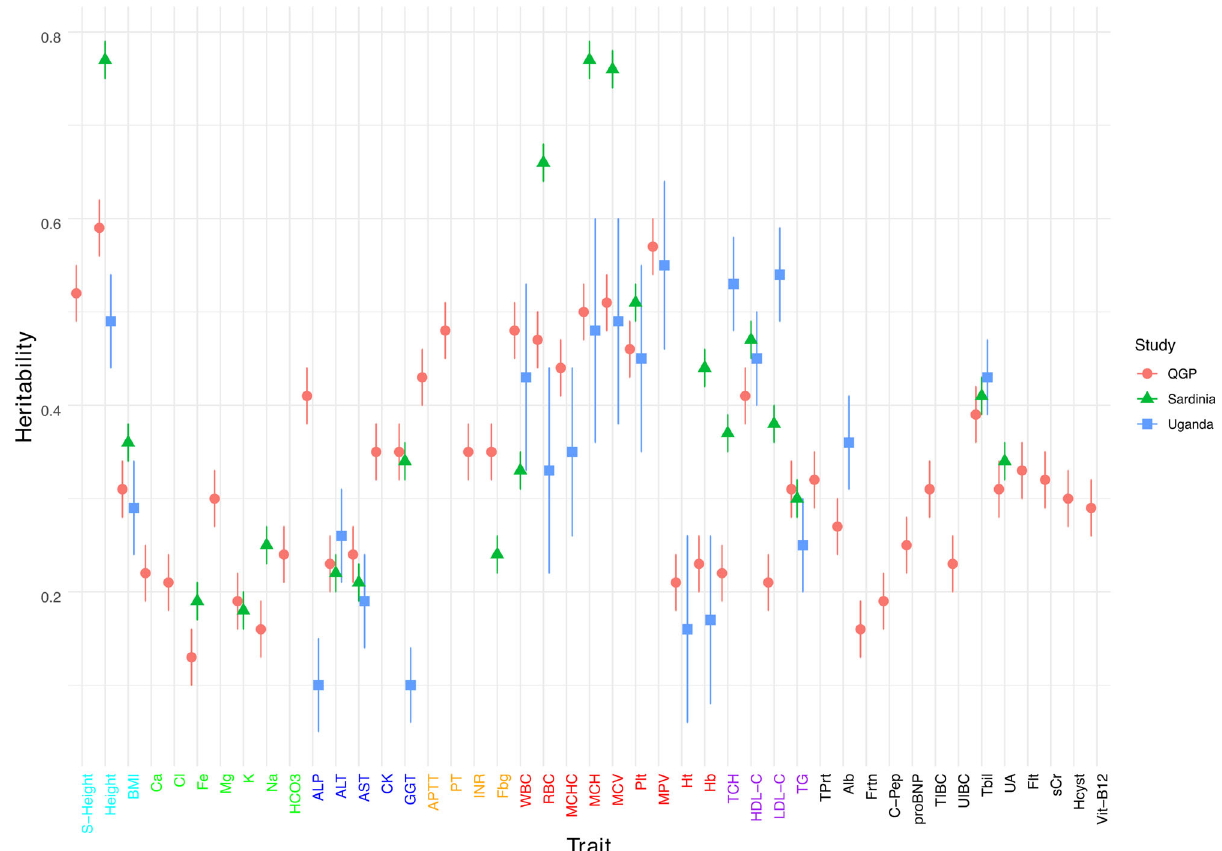
Fig. 1 Heritability estimates of 45 clinically-relevant traits. Heritability estimates of 45 clinically-relevant traits in the Qatar Genome Program cohort (QGP; red markers) compared to estimates from Sardinian (green marker) and Ugandan (blue markers) populations. The heritability estimates in QGP was adjusted for age, gender, the fi rst four population principal components and relatedness. The heritability estimates for several traits in QGP were signi fi cantly different from European 10 and African 6 Populations (Supplementary Table 2). Refer to Table 1 for trait abbreviations. Data are presented as mean ±